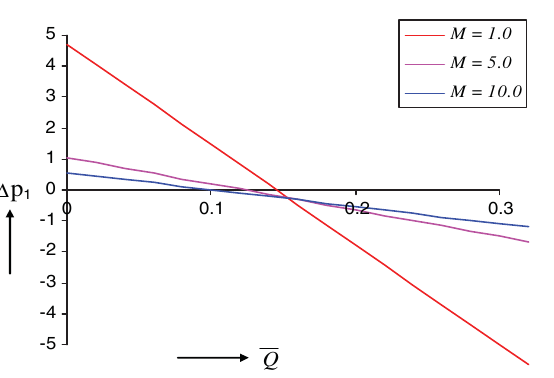
Fig. 12. Average flow rate vs. amplitude, based on Eq. (45). Curves represent reflux limit for N =0.0, 0.9, φ =0.4 and M =0.1.